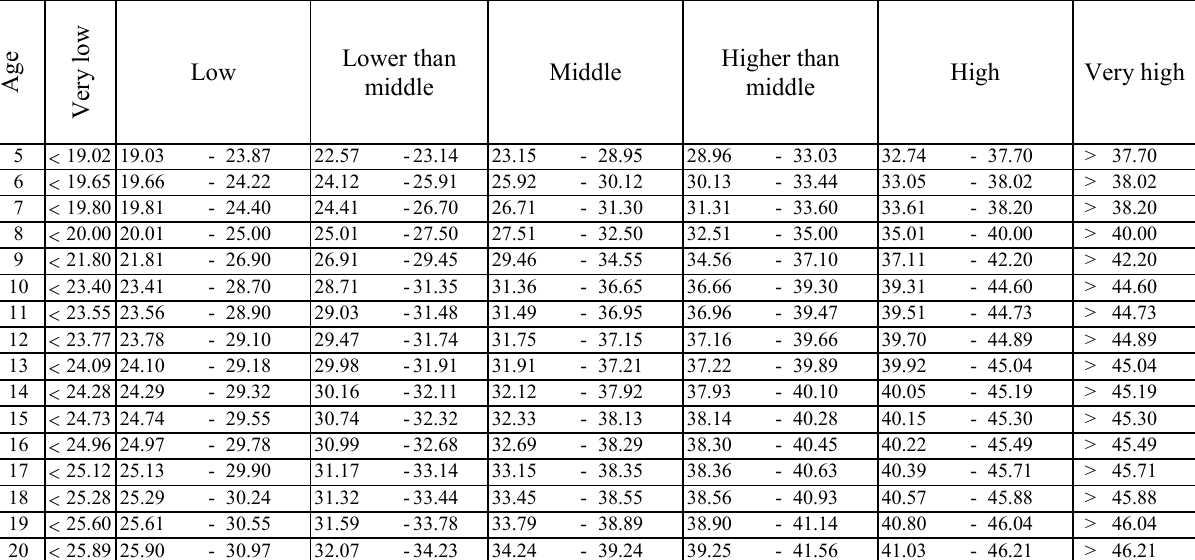
St andards for evaluation of the height of longitudinal foot arch of 5-20 years old sportswomen (mm) [10]